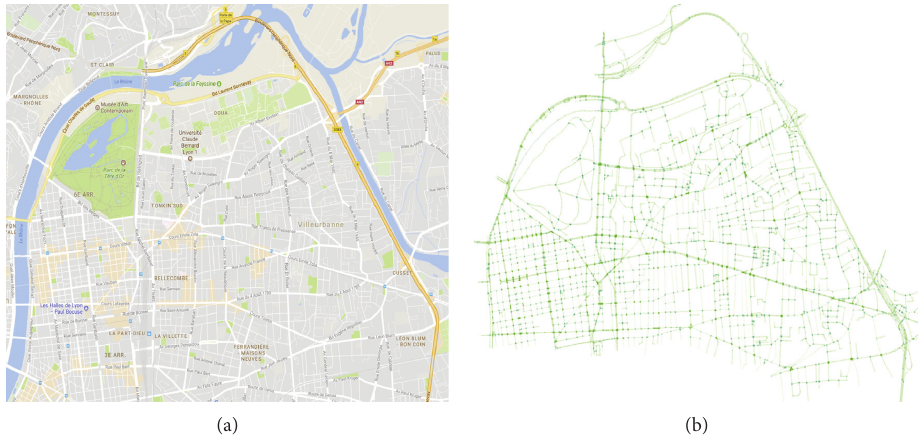
Figure 2: Lyon 6th+Villeurbanne: (a) mapping data ©Google 2020; (b) the traffic network considered in Symuvia.